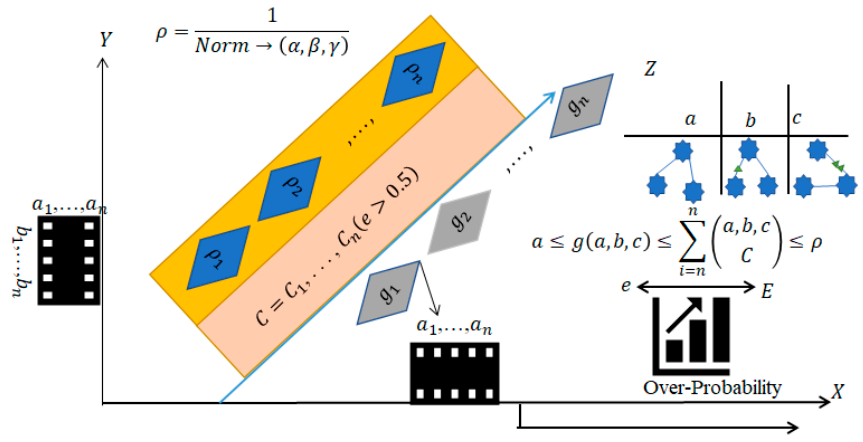
16 of 27 Figure 6. Logical illustration of complex error function in terms of LE and GE spread in each dimen- sion. Overfitness (z) is observed to be reduced in the 𝑥 and 𝑦 coordinates. The primary purpose of GG is to maintain the point in the area where the mistake “err” is acceptable.